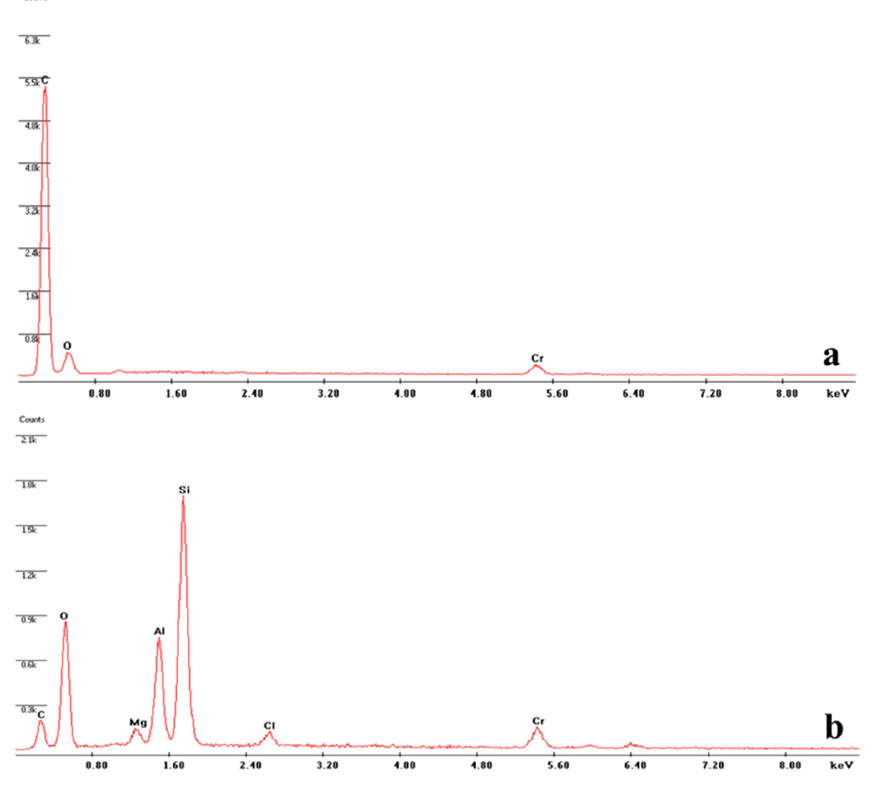
Figure 3. EDX spectrum of the ( a ) COOH-PPy/GCE and ( b ) NH 2 -NCY/COOH-PPy/GCE.